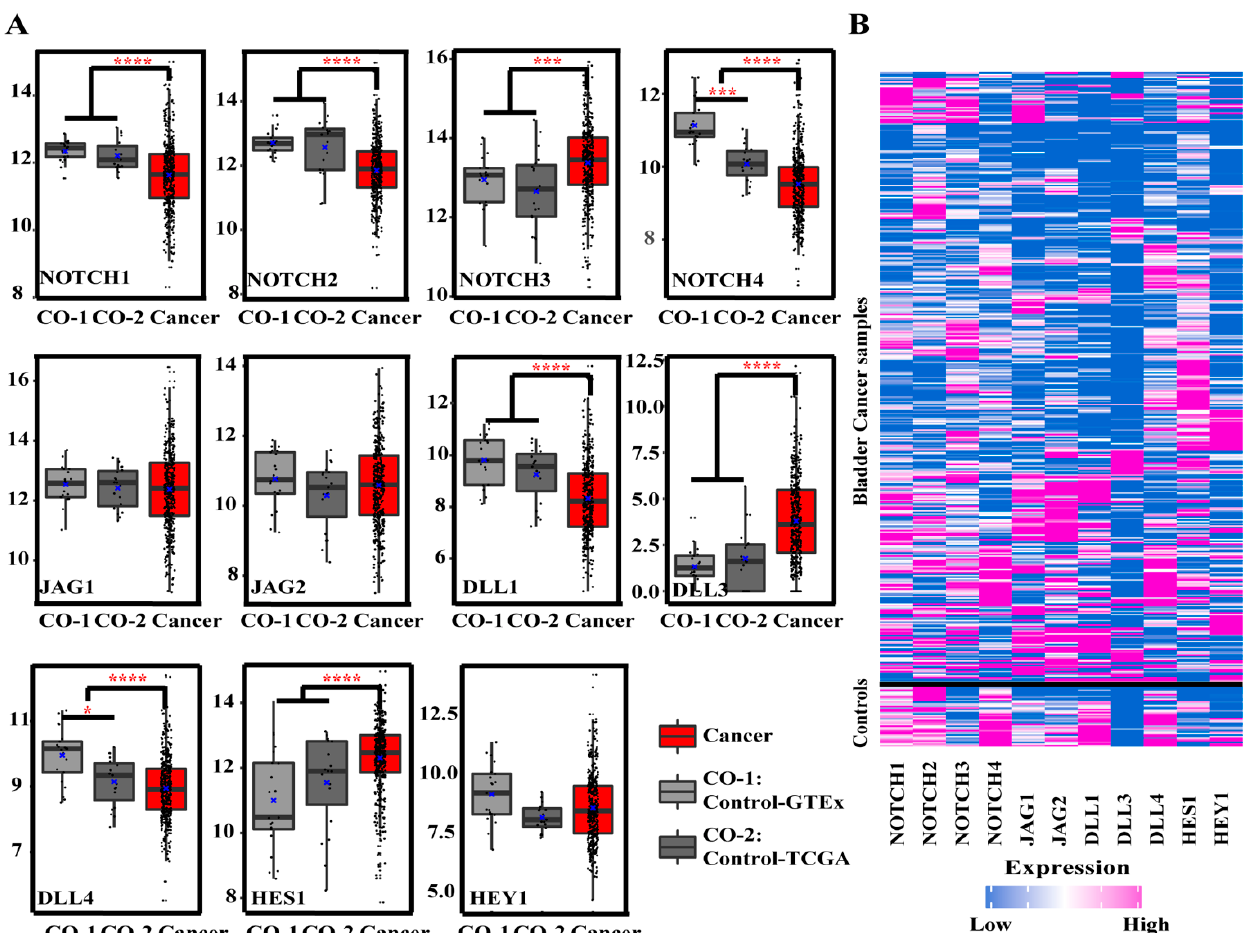
Figure 2. Expression levels of target genes in the control group and BCa samples. ( A ) Box plots of research gene expression levels between control samples (gray, n = 40) and BCa samples (red, n = 406). y -axis = Log 2 (read count value). Controls comprise normal bladder samples from GTEx (CO-1 = control-GTEx, n = 21) and non-cancerous bladder samples from TCGA-BLCA (CO-2 = control-TCGA, n = 19), and significance levels are marked as * p -value < 0.05, *** p -value < 0.001, **** p -value < 0.0001. ( B ) Heatmap of expression levels (color-coded). High expression marked in pink; low expression marked in blue.